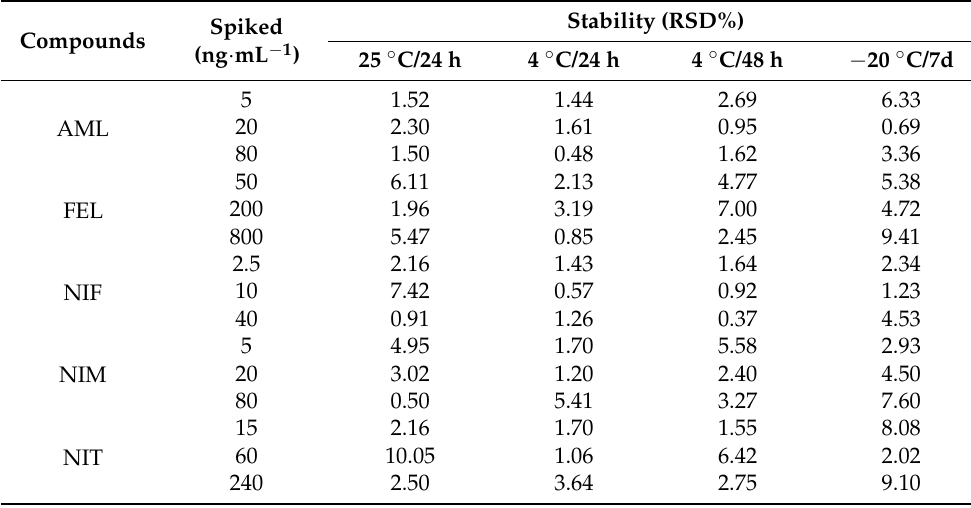
Table 3. The stability of the QC samples under four different conditions ( n = 3). Compounds